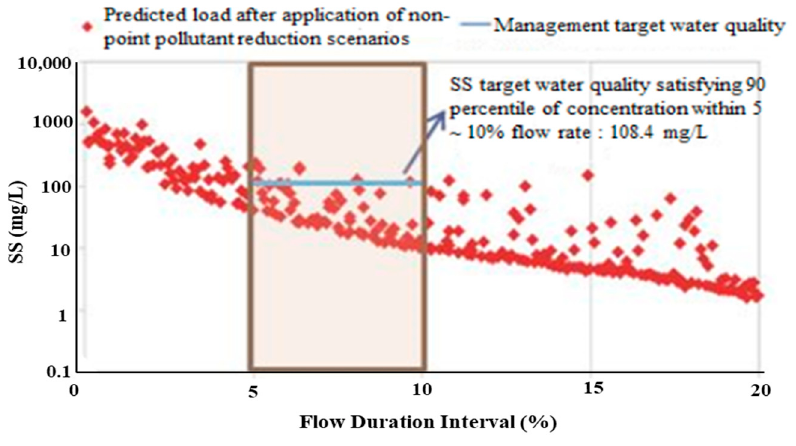
Figure 12. Example of settingwater quality target using concentration distribution.